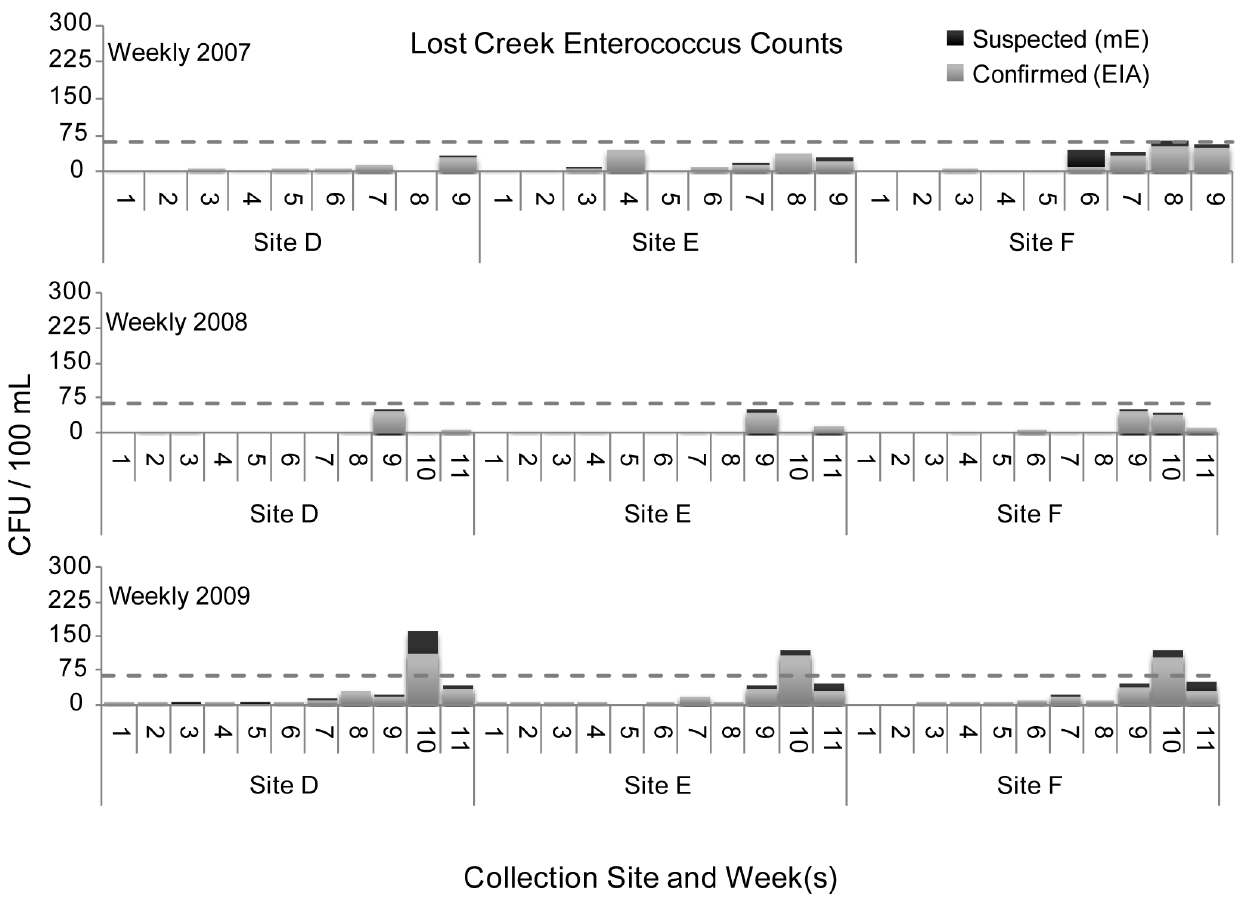
Figure 7. Lost Creek Enterococcus counts.